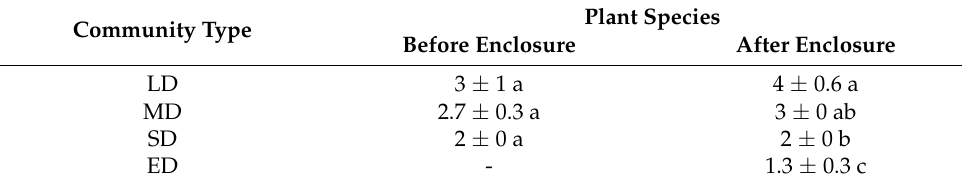
Table 3. Plant species in different desertified grasslands.